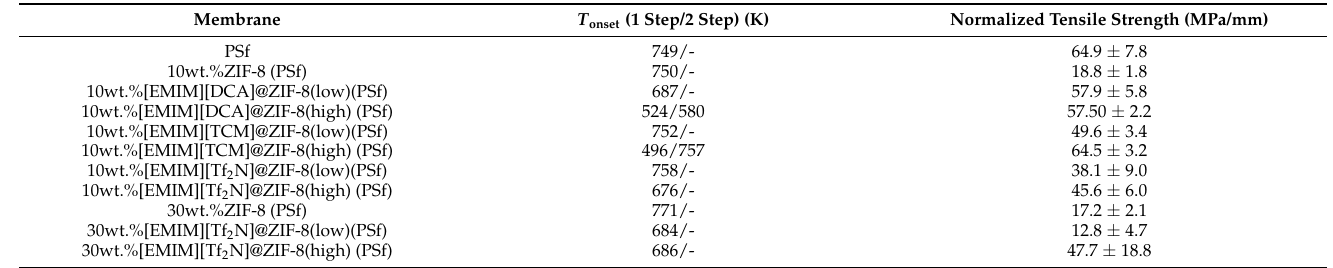
Table 2. Decomposition temperature ( T onset ) and normalized tensile strength of the prepared MMMs compared to pristine PSf. Membrane T onset (1 Step/2 Step)